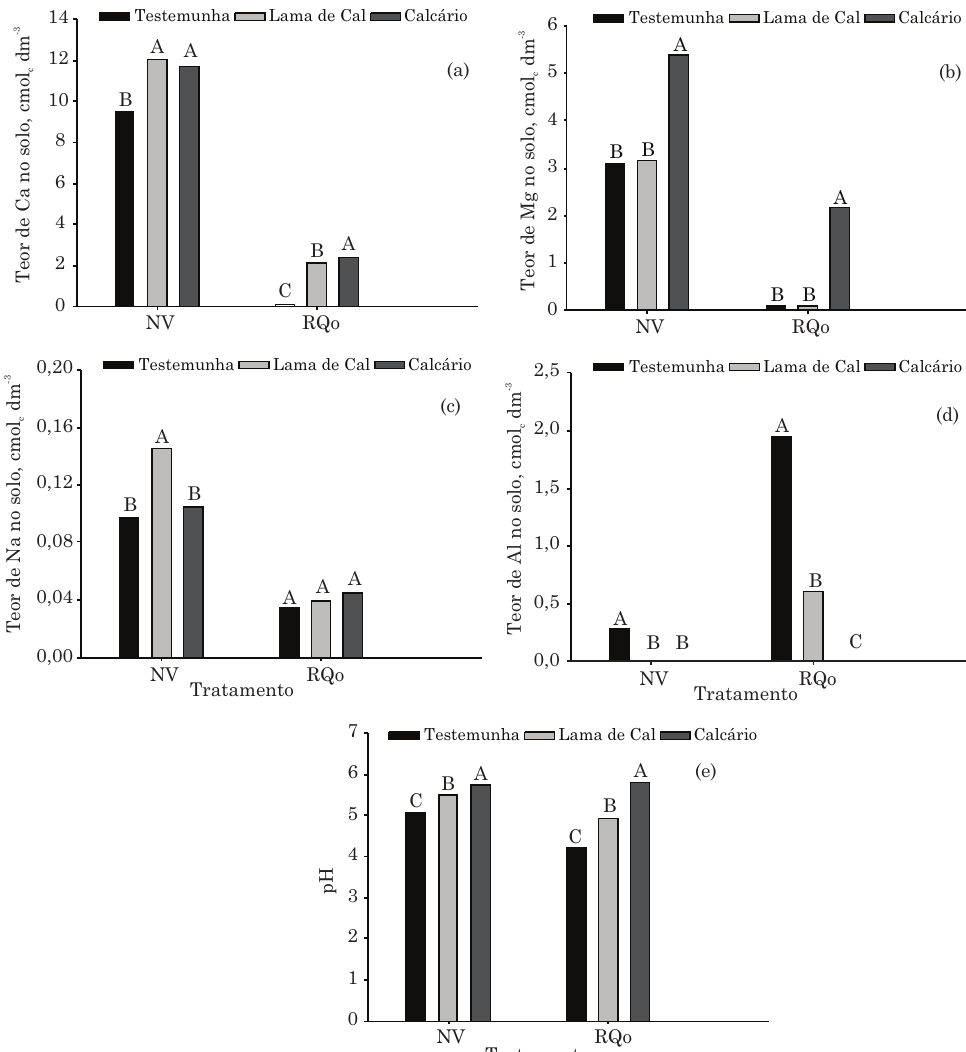
Figura 3. Teores de Ca (a), Mg (b), Na (c) e Al (d) e valor de pH (e) no solo, após cultivo de Eucalyptus saligna em Nitossolo Vermelho eutroférrico (NV) e Neossolo Quartzarênico órtico (RQo), em função da aplicação de calcário e lama de cal. Médias seguidas da mesma letra, no mesmo solo, não diferem significativamente pelo teste de Tukey a 5